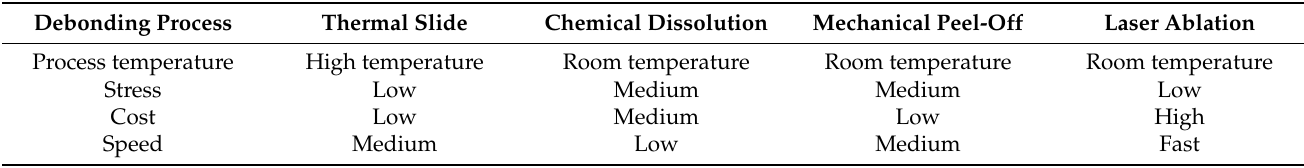
Table 3. Comparison of different TBDB technologies.